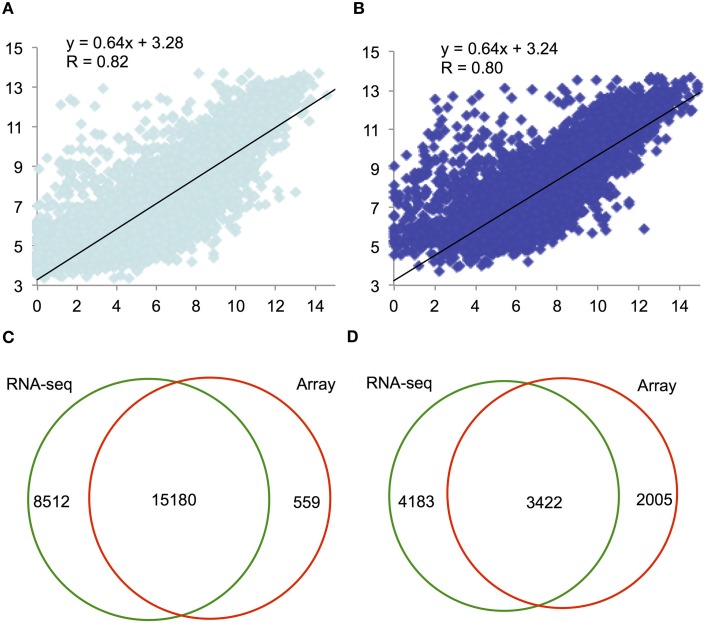
A scatter plot of relative expression values obtained by RNA-seq and microarray for F1–9 and F12. (A) Comparison of expression levels between RNA-seq and microarray for F1–9, RNA-seq and microarray; gene expression levels transformed with log2 were plotted. (B) Comparison of expression between RNA-seq and microarray for F12. (C) A Venn diagram illustrating genes detected by RNA-seq (left) and microarray (right) analyses. (D) A Venn diagram presenting the overlap of differentially expressed genes between F1–9 and F12 from RNA-seq (left) and from microarray analysis (right).